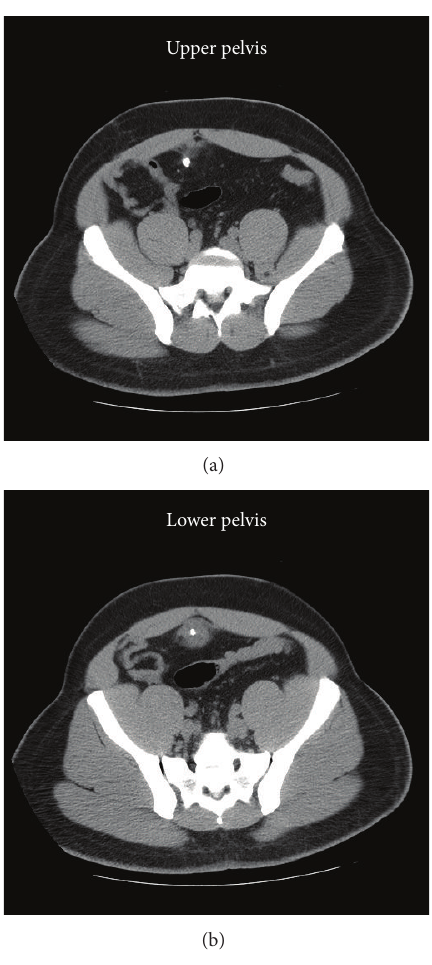
Figure 3: Incidental urachal cyst with calcification without any surrounding